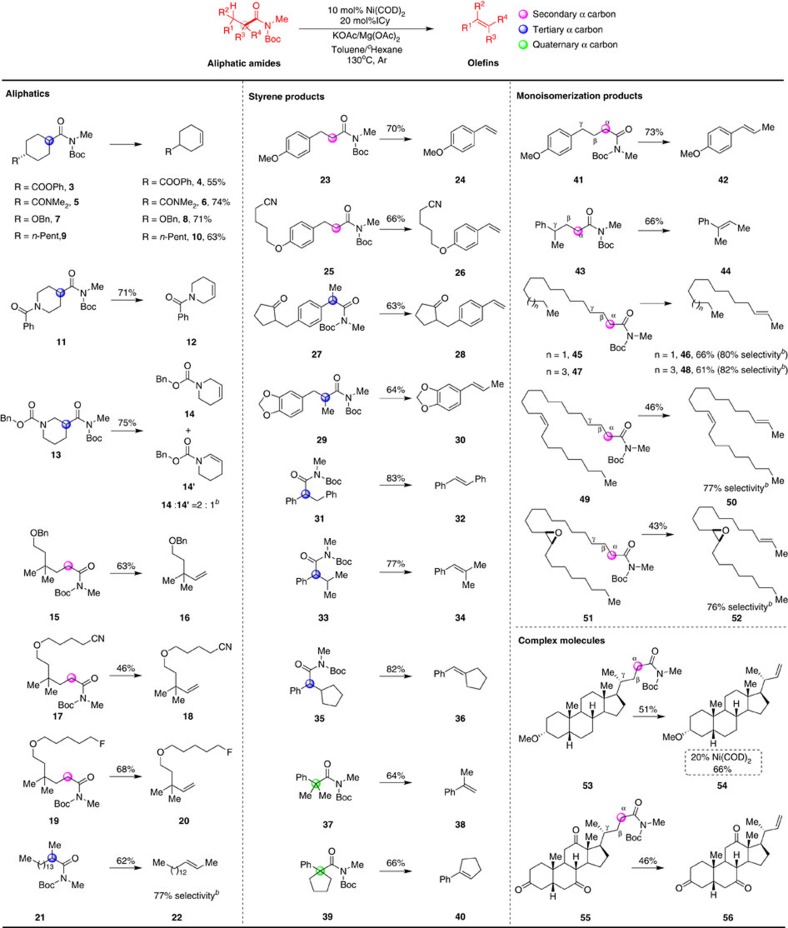
Scope of the aliphatic amide retro-hydroamidocarbonylation.Reaction conditions: amides (0.20 mmol), 10 mol% of Ni(COD)2, 20 mol% of ICy, 0.5 equiv of Mg(OAc)2, 3.0 equiv of KOAc in 3.0 ml toluene/chexane (v/v=1:2) at 130 °C, 36 h, under Ar. aIsolate yield. bDetermined by crude 1H NMR.